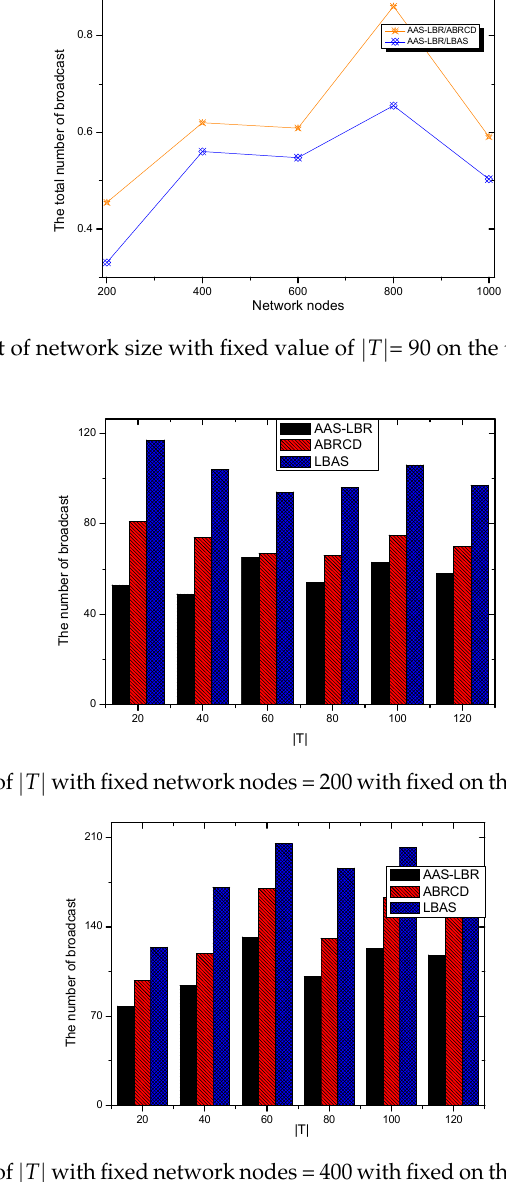
Figure 42. The impact of | T | with fixed network nodes = 400 with fixed on the total number of